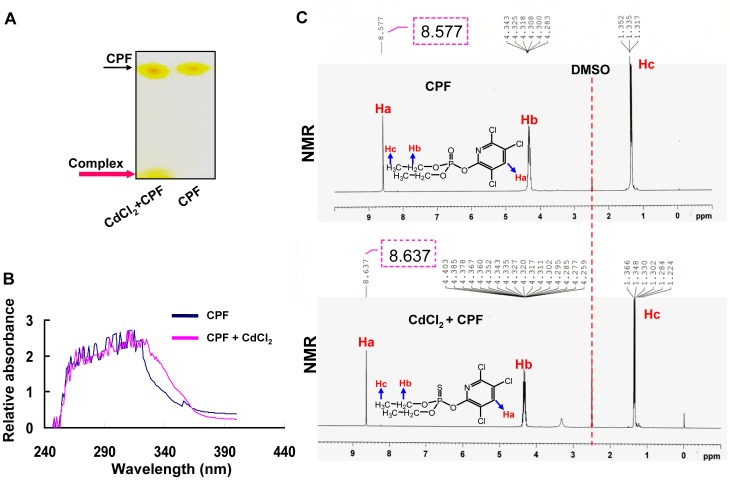
The characterization of Cd2+ and CPF interaction.(a) Molecular interaction analysis of Cd2+ and CPF was determined by TLC. (b) The UV-vis absorption spectrum analysis of CPF and Cd2+ reaction mix. (c) The NMR spectroscopy identified the reaction between Cd2+ and CPF. The representative images of the NMR spectra indicated that Cd ion caused great chemical shift of Ha in the pyridine ring of CPF, which decreased the electron cloud density of nitrogen atom and sulphur atom.